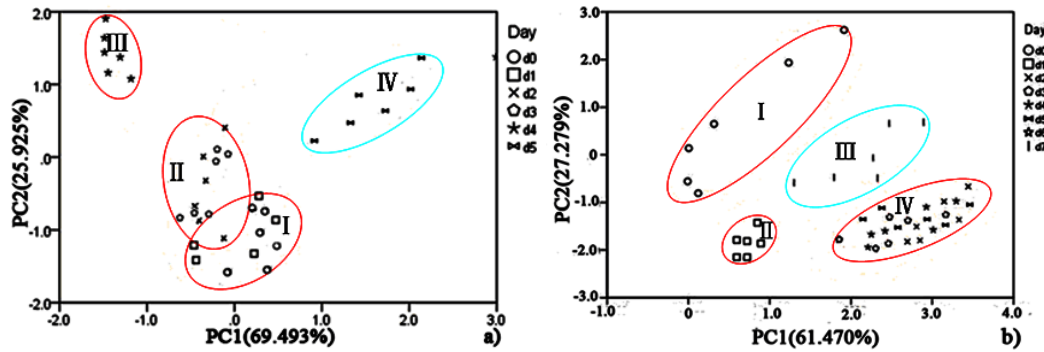
Figure 12. Score plots of PCA at 5 °C for hairtail fish ( a ) and pork ( b ) (PCA